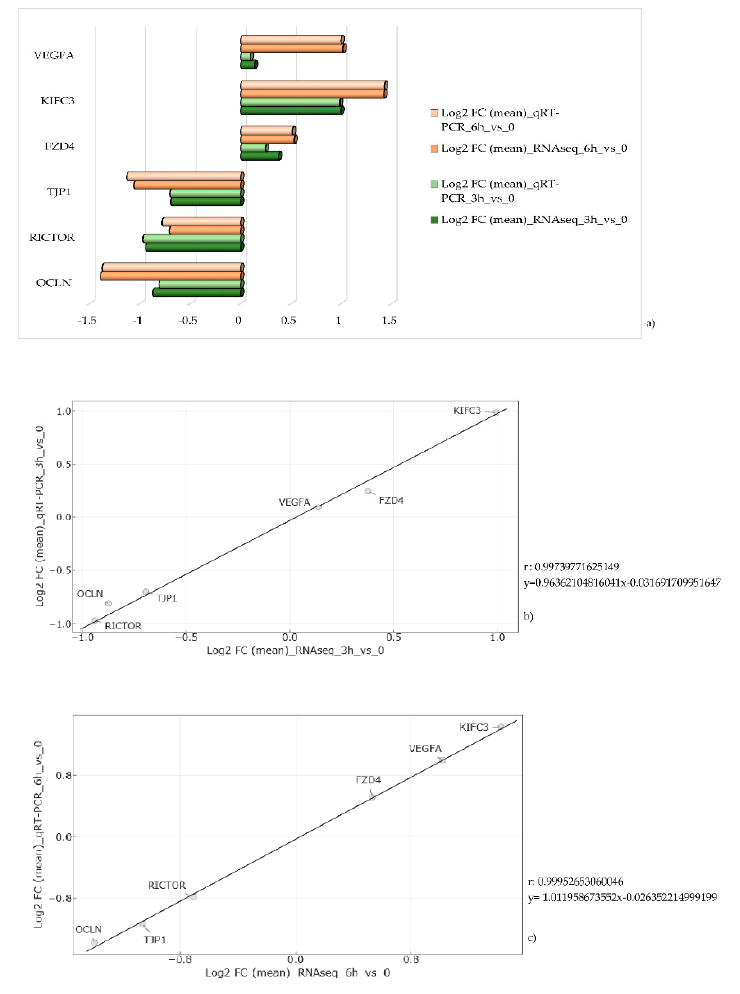
Figure 4. Real-time PCR results and correlation analysis. ( a ) The bar charts show a comparison between expression values (as log 2 fold change (FC)) observed by qRT-PCR and RNA sequencing. Represented values are the average of the three replicates. ( b , c ) Correlation analysis between log 2 FC observed values by RNAseq ( x -axis) and qRT-PCR ( y -axis) at the first ( b ) and at the second ( c ) time point.